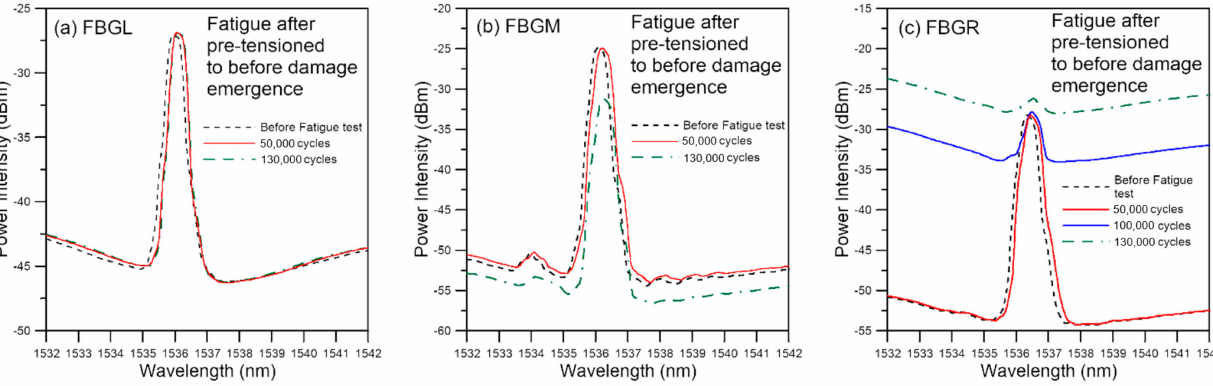
Figure 13. Evolution of unload FBG spectra during fatigue cycling of a specimen pre-tensioned to before damage emergence (failure at 134,900